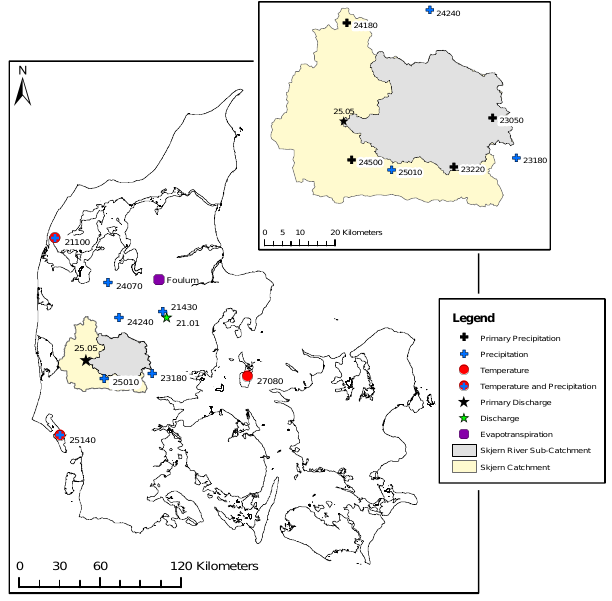
Fig. 1. Map of the study area with precipitation, discharge, and tem- perature